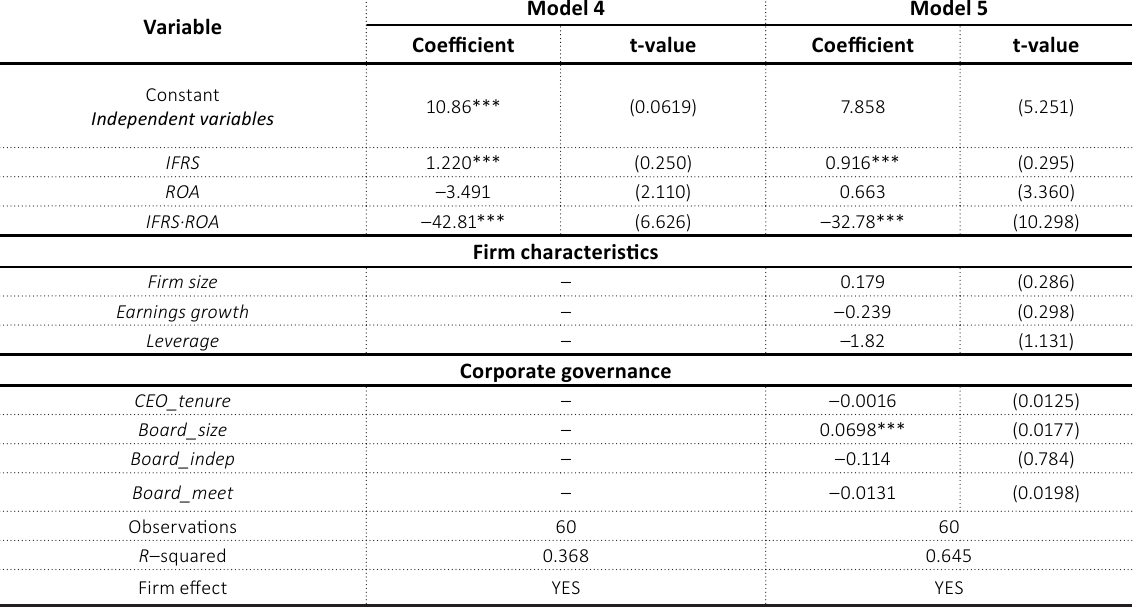
Table 4. Robustness test for fixed effect model